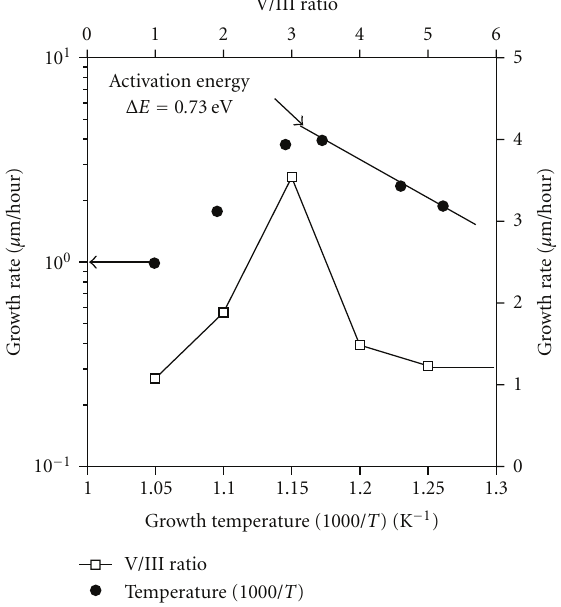
Figure 1: Temperature dependence of the Al 0 . 05 Ga 0 . 95 Sb growth rates and the growth rate of Al 0 . 05 Ga 0 . 95 Sb epilayers grown at 580 ◦ C as a function of V/III